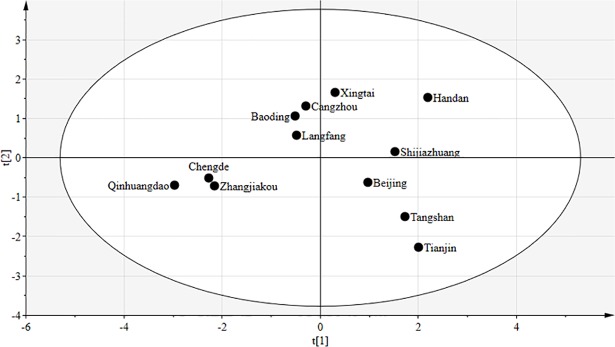
t1/t2 oval plot.